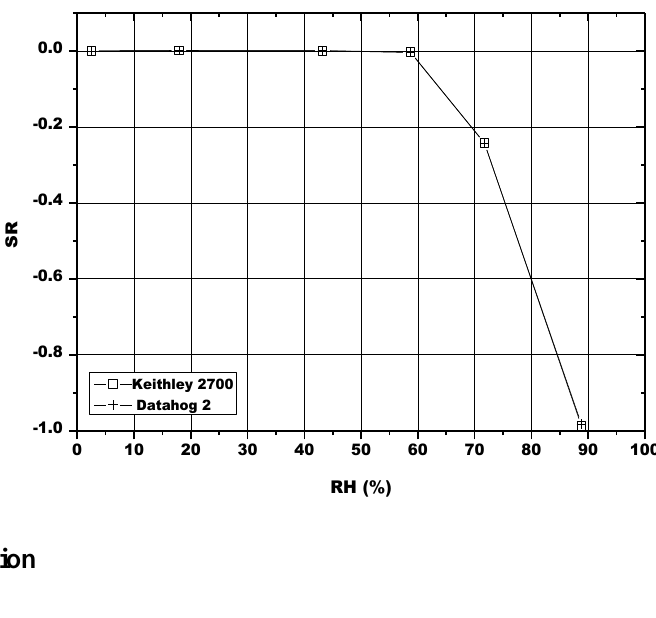
Figure 6. Comparison between the sensor response recorded by the digital multimeter. (Keithley 2700) and by the datalogger (Datahog 2) in function of the relative humidity.